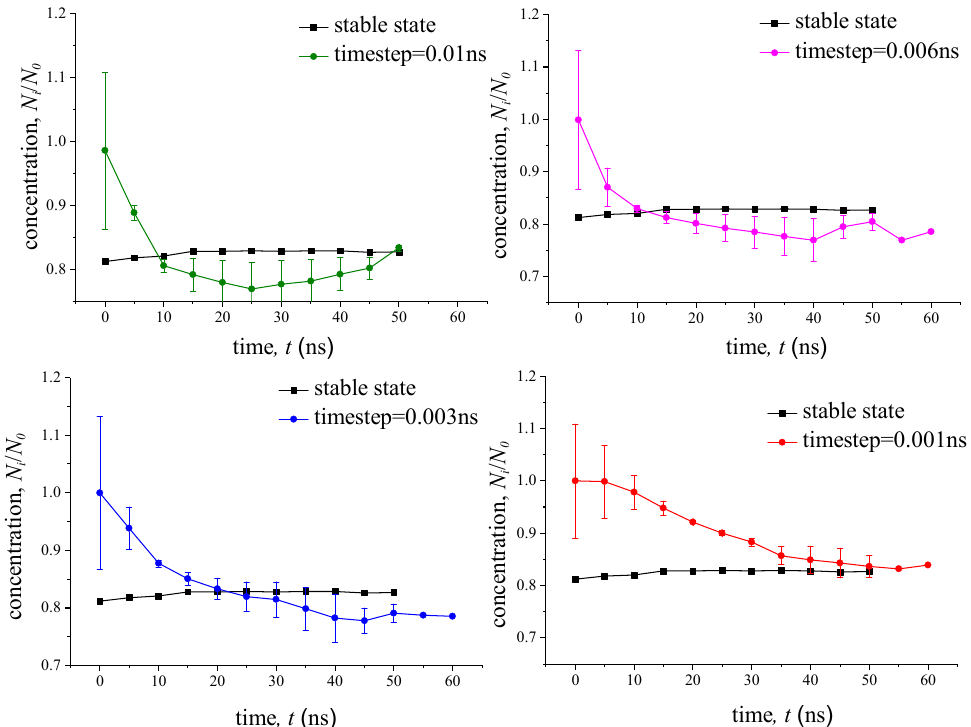
Figure 3. Aggregates concentration with time range (L = 60 ns).